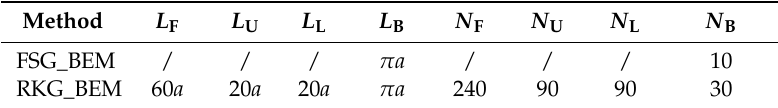
Table 2. Mesh specifications for the case shown in Figure 5. Refer to Table 1 for the notes of the symbols.